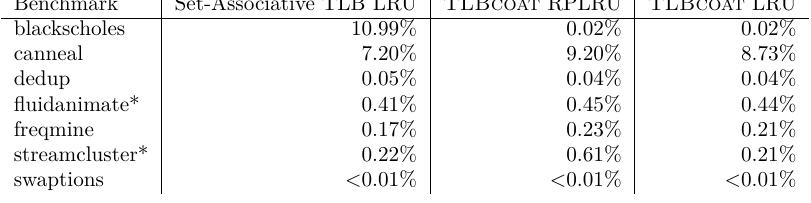
Table 2: PARSEC benchmark results comparing regular set-associative TLBs to TLB- coat by their respective miss ratio. Each benchmark is the only program running on the system apart from some background tasks. Benchmarks marked with a * were run using the simsmall input, the others with simmedium